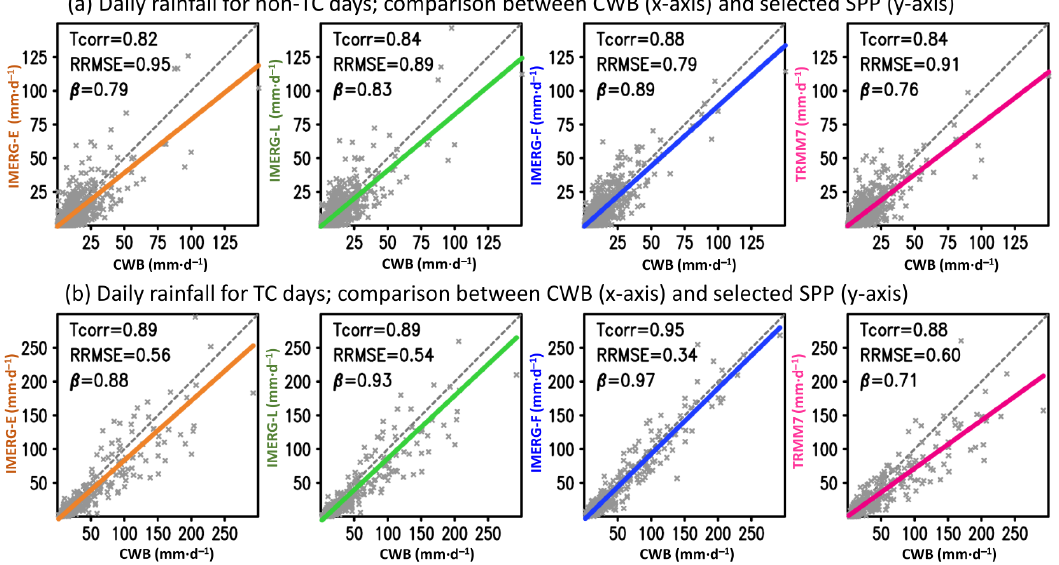
Figure 3. Scatter plots of the daily area-averaged rainfall over Taiwan, estimated from CWB ( x -axis) and selected SPPs ( y -axis), for ( a ) non-TC days and ( b ) TC days during 2000 – 2018 JASO. Plots include the 1:1 line (dotted line), and the least-squares regression line (solid line), using rainfall estimated by CWB as the independent variable and those by SPP as the dependent variable. Statistical values of Tcorr, relative root-mean-square error (RRMSE), and the regression coefficient ( β ) for the comparison between CWB and SPPs are given in the top left corner of each plot. Remote Sens. 2021 , 13 , x FOR PEER REVIEW